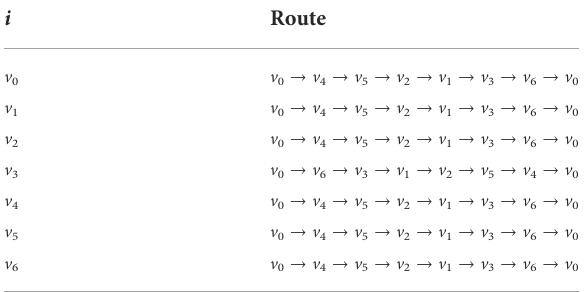
TABLE 5 Multiplier for time spent at each node and shortest route. Multiplier for spent time